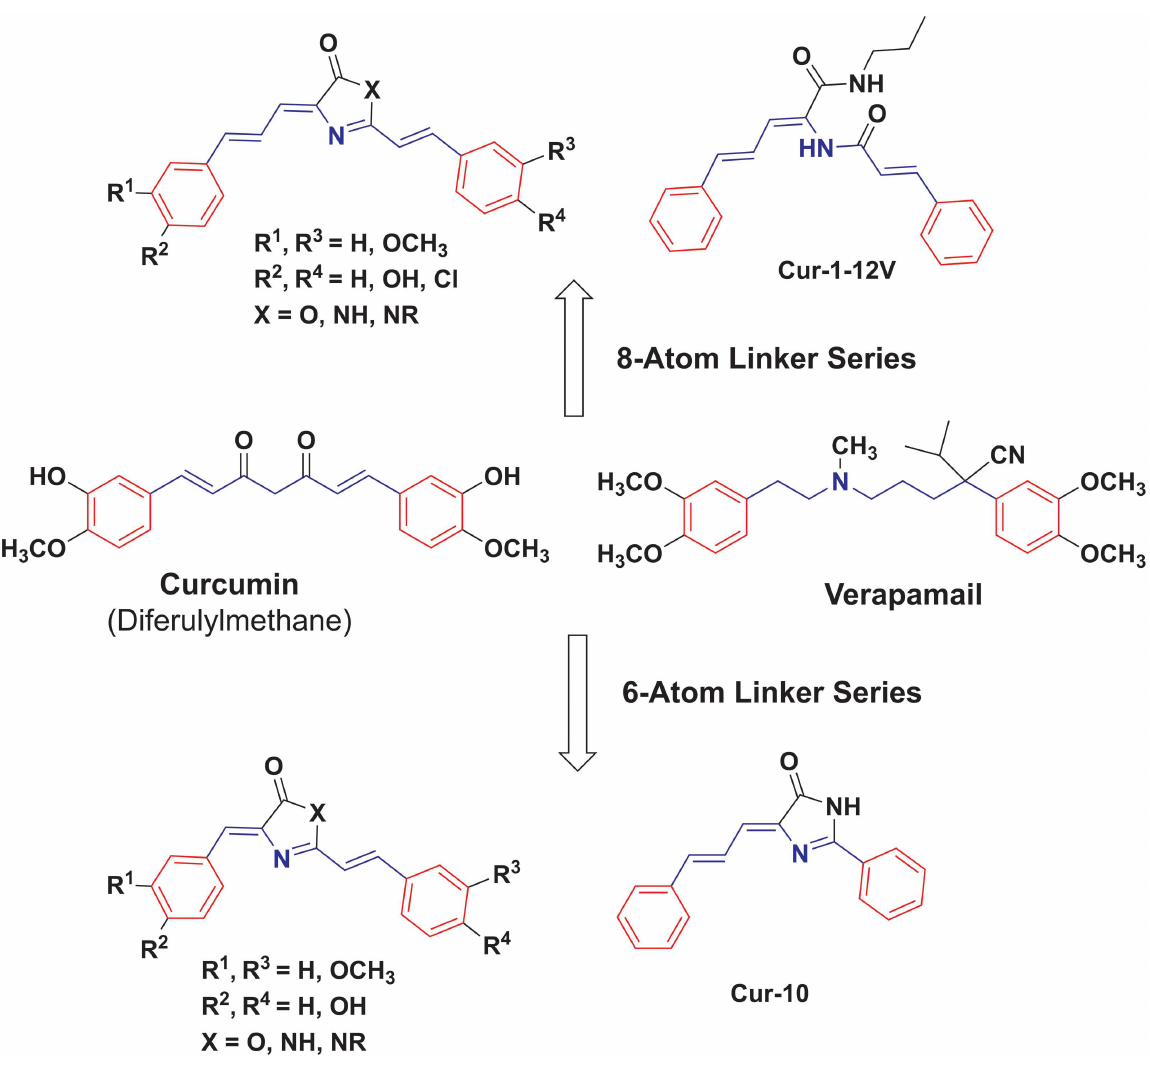
Fig 2. Design of Pgp inhibitors by re-scaffolding of the linker region of curcumin and verapamil.